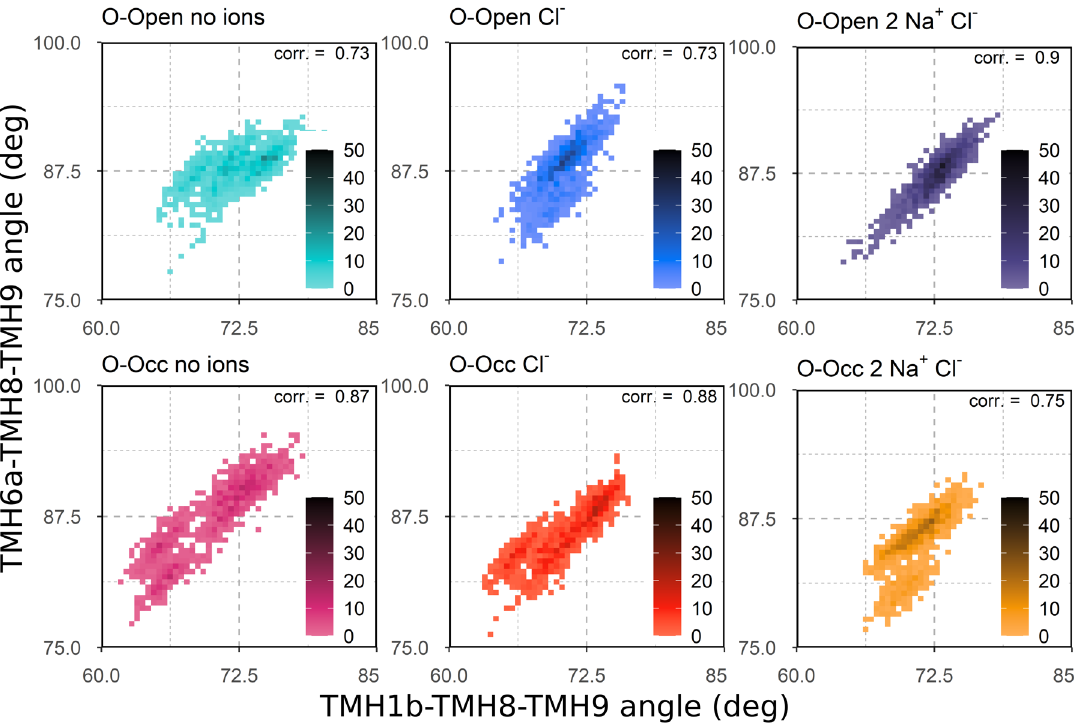
Figure 3. Ion dependences of the correlated motions of TMH1b and TMH6a. The angles between the center of mass of TMH1b–TMH8–TMH9 and TMH6a–TMH8–TMH9 are shown as two-dimensional (2D) histograms. The last 250 ns of 5 parallel simulations with a 1 ns temporal resolution were used. Angles are measured in degrees (deg). Pearson correlation coefficients (corr) are reported at the upper right corner of each plot.